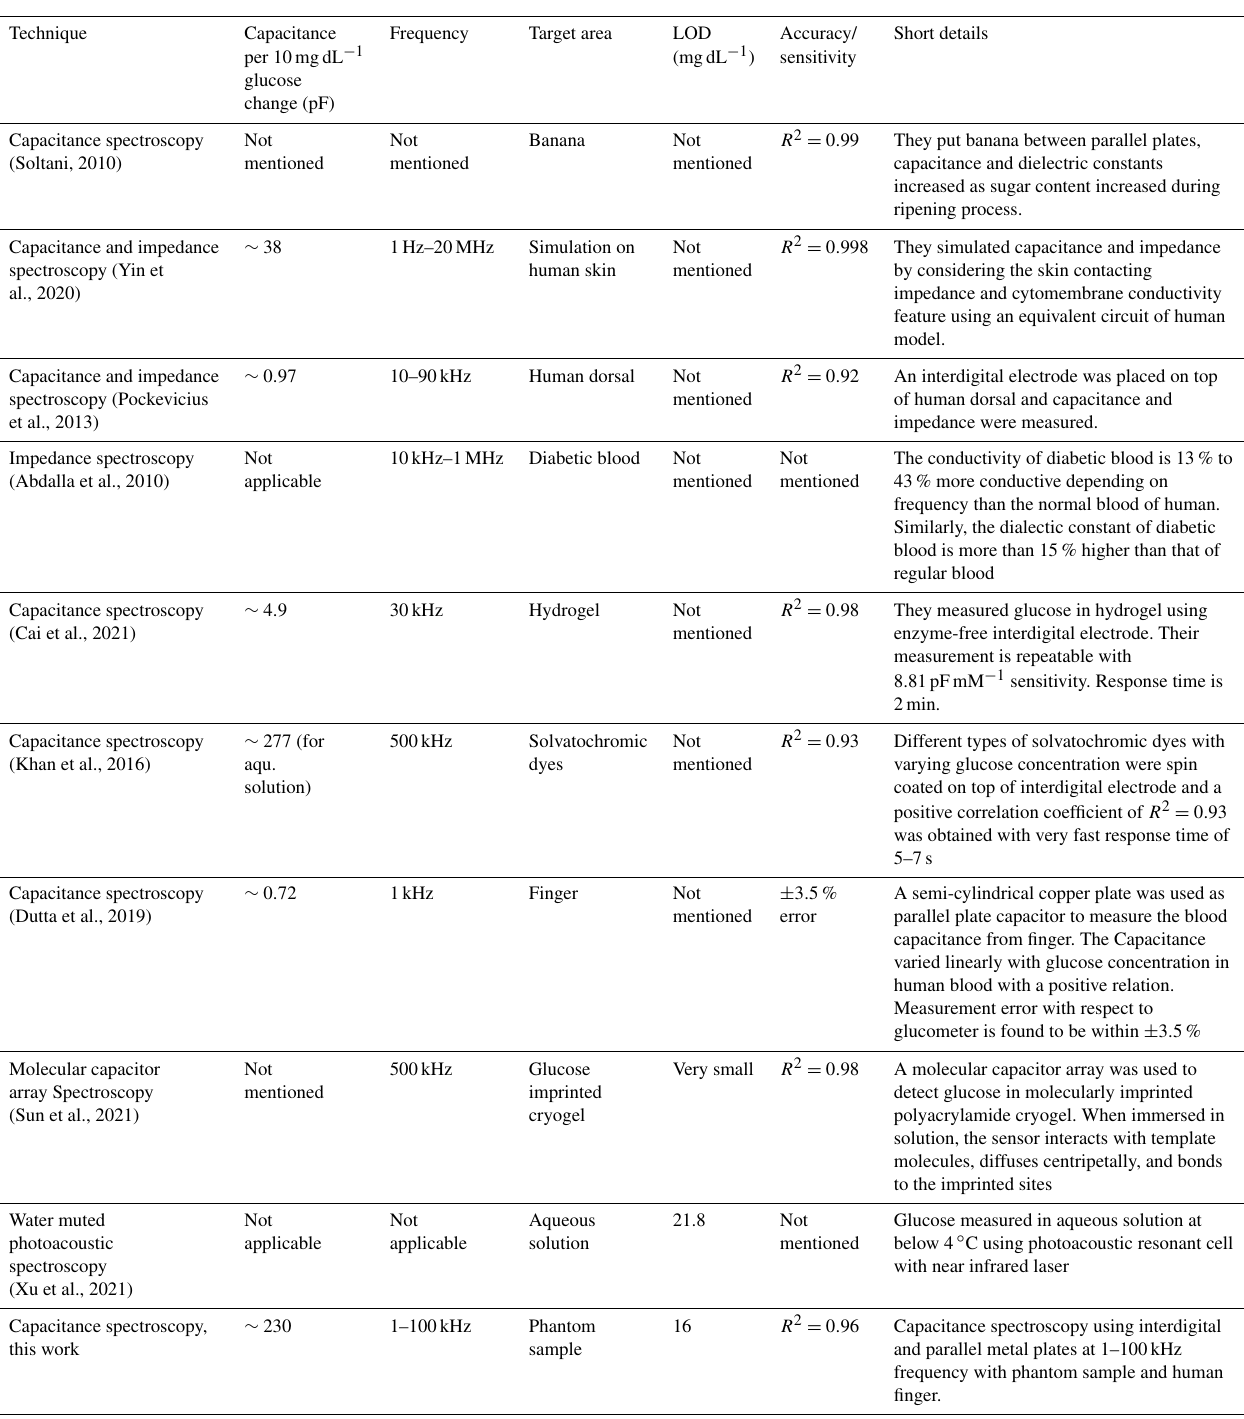
Table 1. Contemporary glucose detection techniques and their